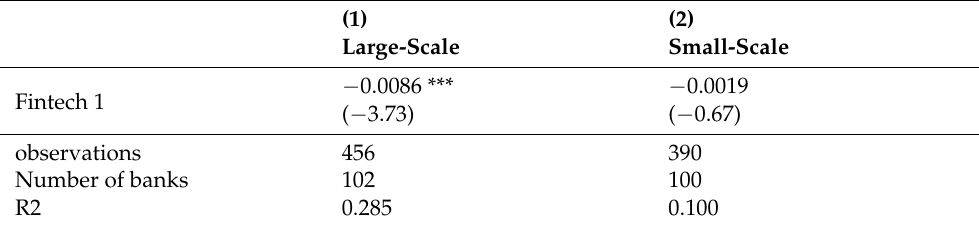
Table 11. Heterogeneity test results of bank size.